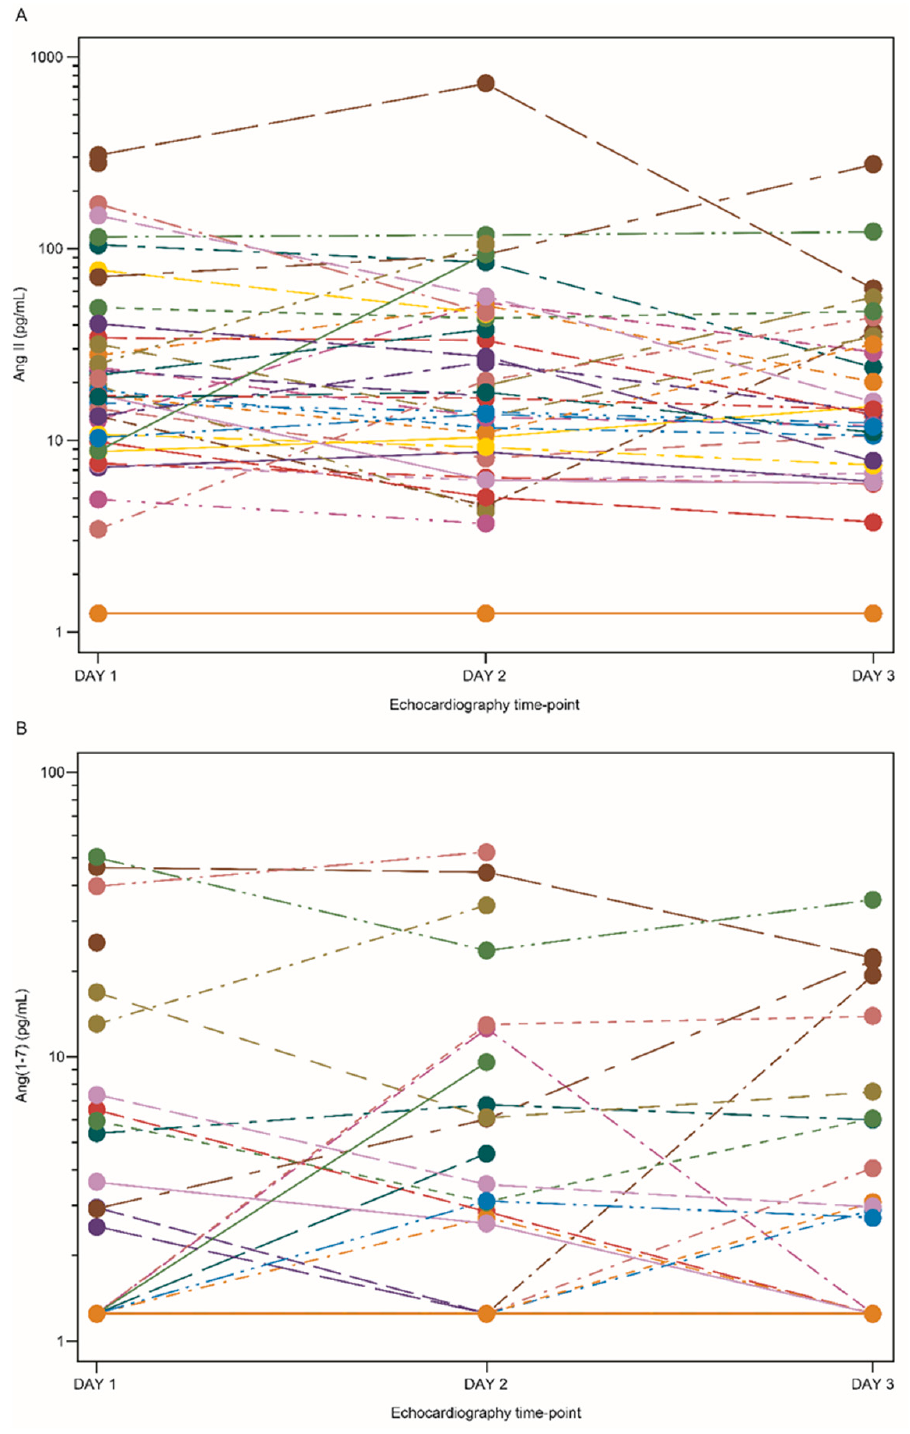
Figure 3. Individual time profile of ( A ) Ang II and ( B ) Ang(1–7) concentrations by time point. Ang angiotensin.